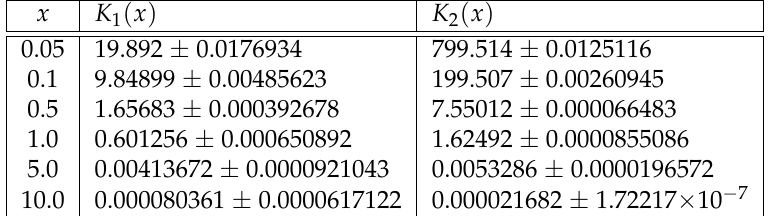
Table 3. Values for K 1 ( x ) and K 2 ( x ) obtained from Equations (9) and (10) up to n = 8. The error here is the difference between the value found and the expected value